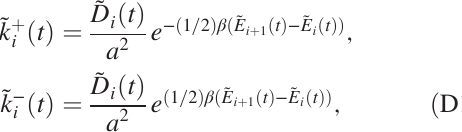
ffiffiffiffiffiffiffiffiffiffiffiffiffiffiffiffiffiffiffiffiffiffiffiffiffiffiffi ρ i þ 1 ð